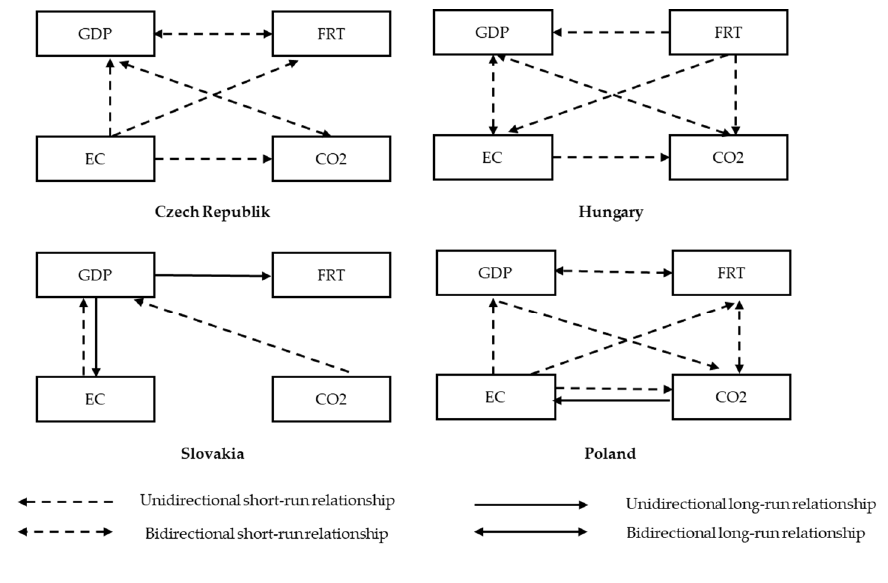
Figure 5. Graphical result of the obtained results—short and long-run relations. The results, thus, show that the assumed hypothesis 1 (H1) is only valid for Slovakia. Hypothesis 2 (H2) was confirmed for the Czech Republic and Slovakia. In contrast, hy- pothesis 3 (H3) is valid for the Czech Republic, Poland and Hungary.